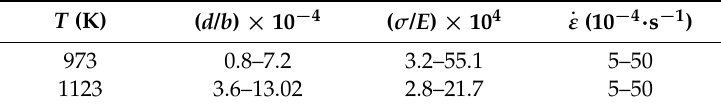
Table 4. Calculated results for the superplastic deformation of Ti-6Al-4V alloy.